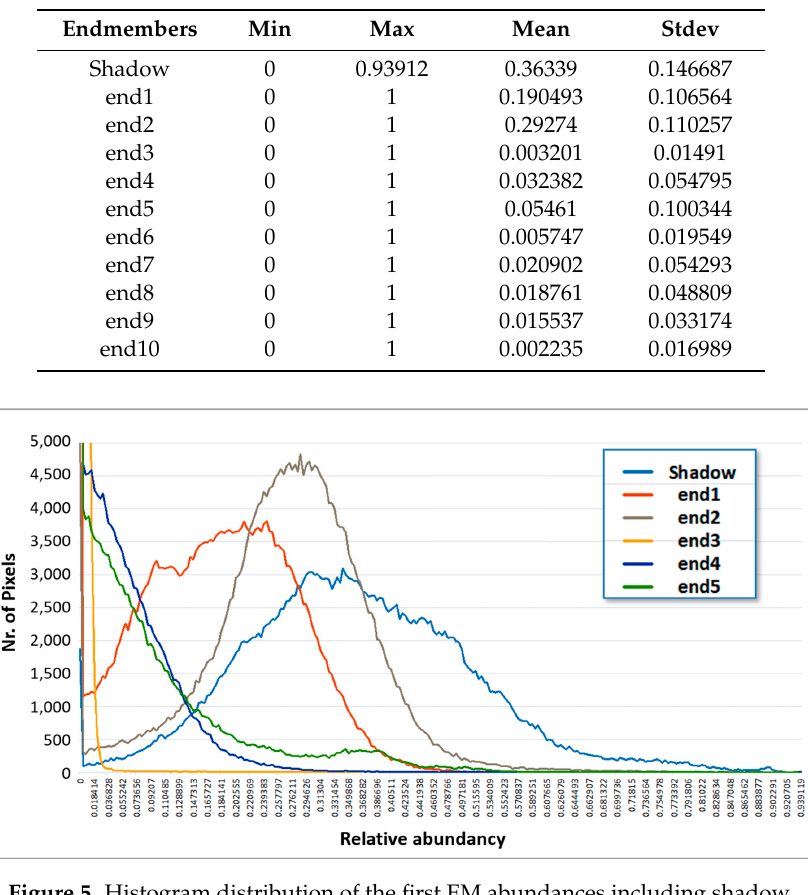
Table 2. Basic statistics for the EMs abundance distribution of WV3 pansharpened data.